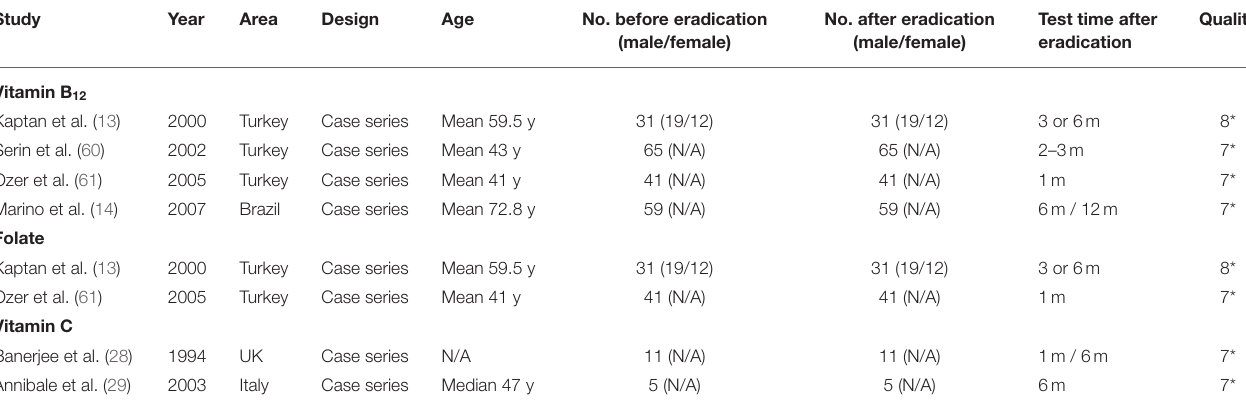
TABLE 3 | Basic characteristics of studies comparing serum vitamin levels before and after H . pylori eradication